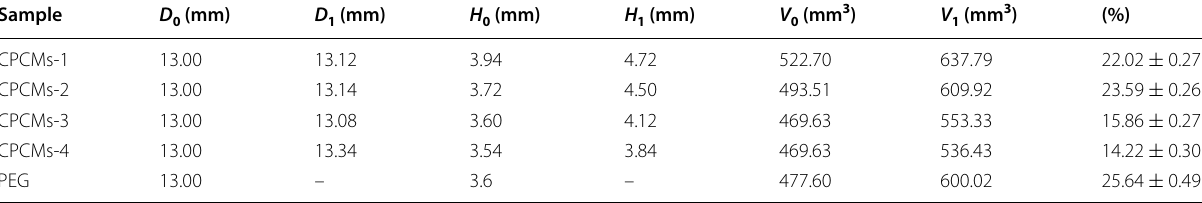
Table 4 The height, diameter, and volume change of tablet samples